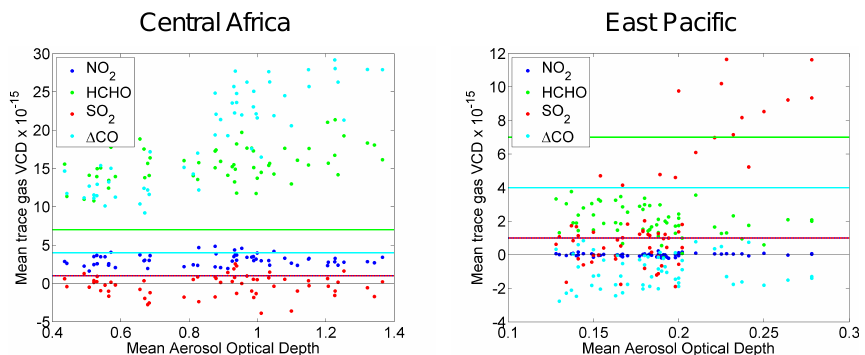
Figure 3. Relationship between 1 ◦ × 1 ◦ monthly mean values of AOD and trace gas columns (in moleccm − 2 ) for a region in central Africa (2–4 ◦ S, 18–20 ◦ E; left panel) and in the eastern Pacific Ocean (16–18 ◦ N, 162–164 ◦ W; right panel) for July–August 2007–2011. Dots depict NO 2 (blue), HCHO (green), and SO 2 (red) VCDs and excess CO VCDs (light blue, scaled by a factor of 0 . 01) and their respective thresholds. The threshold values of NO 2 and SO 2 are identical (dotted blue and red lines). Note the differences in y axis